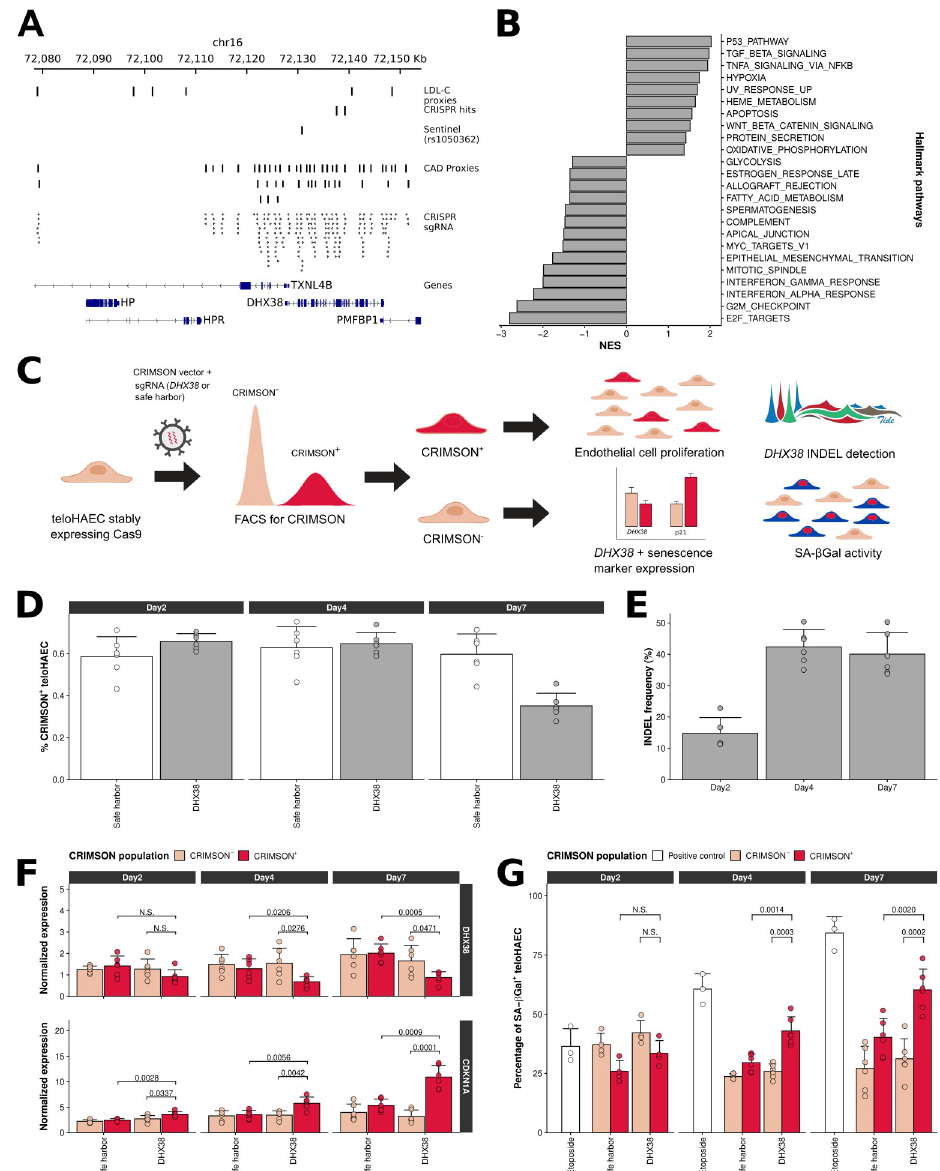
Fig 5. Disruption of DHX38 induces vascular endothelial cell senescence. ( A ) Perturbations with the Cas9 nuclease highlighted two synonymous variants (rs2074626, rs2240243) in the DHX38 gene for several endothelial phenotypes. DHX38 is located downstream of the HP and HPR genes, which have previously been associated with LDL-C levels. However, the CAD and LDL-C GWAS signals are distinct based on co-localization analyses (posterior probability for two independent association signals (H3) = 80.9%). ( B ) Gene-set enrichment analysis results for differentially expressed genes identified by RNA-seq in teloHAEC between a sgRNA targeting a DHX38 coding exon and a safe harbor negative control sgRNA. Only pathways with a Benjamini-Hochberg-corrected P-value < 0.05 and normalized enrichment scores (NES) < -1 or > 1 are shown. ( C ) Experimental design for the characterization of DHX38 using the fluorescent marker CRIMSON in place of an antibiotic resistance gene. We did all experiments in teloHAEC that stably express Cas9. We monitored the impact of a DHX38 sgRNA on cell proliferation, indel induction, gene expression and senescence-associated β -galactosidase (SA- β Gal) activity. ( D ) Comparison of endothelial cell proliferation between teloHAEC with a DHX38 sgRNA or a safe harbor negative control sgRNA. The differences in the number of CRIMSON + cells were not significant two or four days post-infection. However, there were 27% less CRIMSON + cells with DHX38 sgRNA relative to the safe harbor control at seven days post-infection (Student’s t -test P -value = 7.3x10 -8 ). Results are mean ± standard deviation for 6 replicates for safe harbor and three replicates for two DHX38 targeting sgRNA. ( E ) Quantification of DHX38 indels by tracking of indel by decomposition (TIDE) analysis.